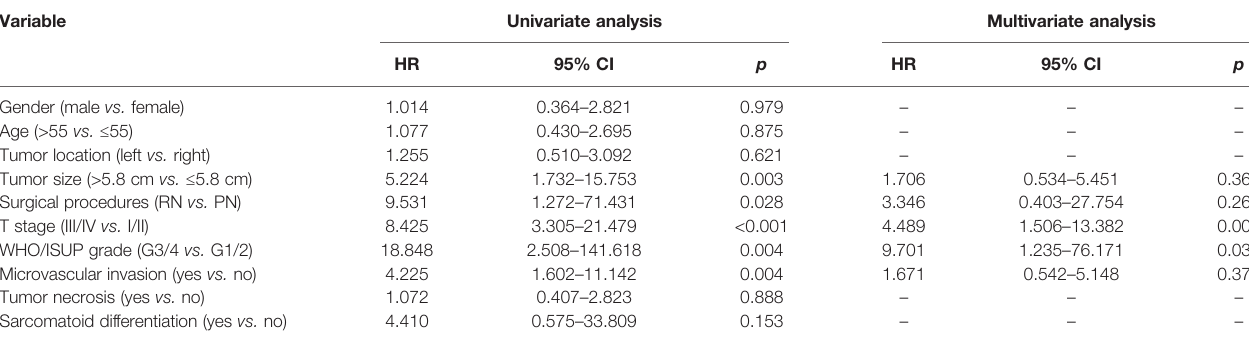
TABLE 3 | Univariate and multivariate Cox regression analyses of factors predictive of overall survival in type 2 PRCC patients. Variable Univariate analysis Multivariate analysis